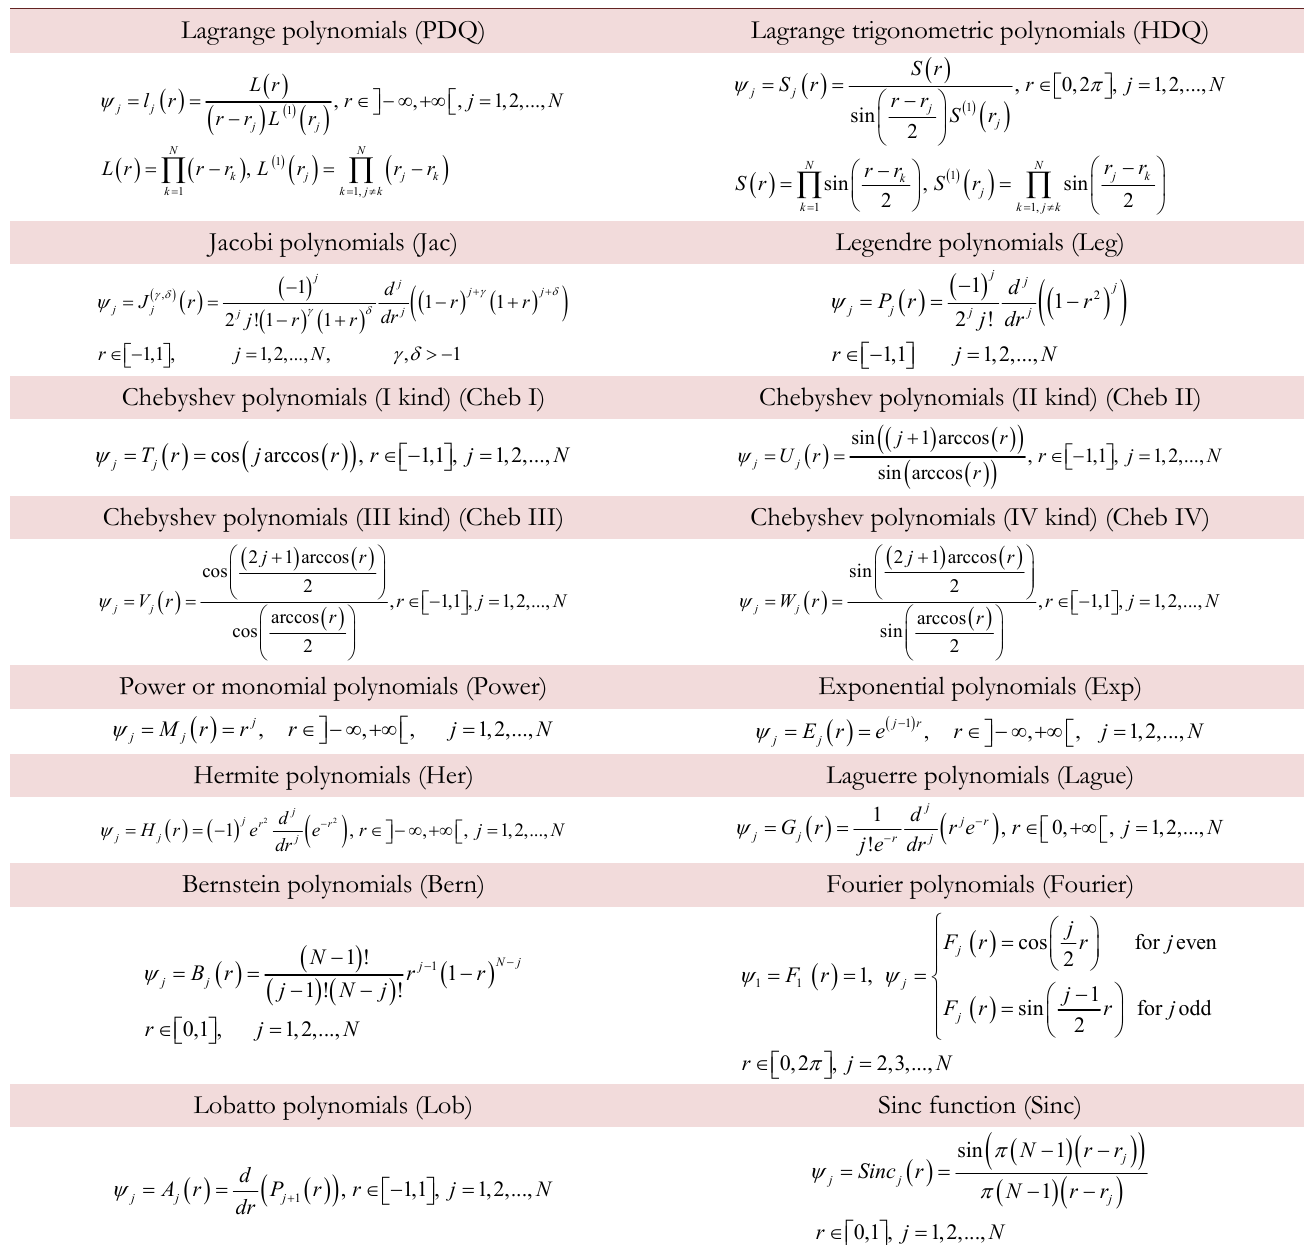
 and their definition interval used in structural mechanics j